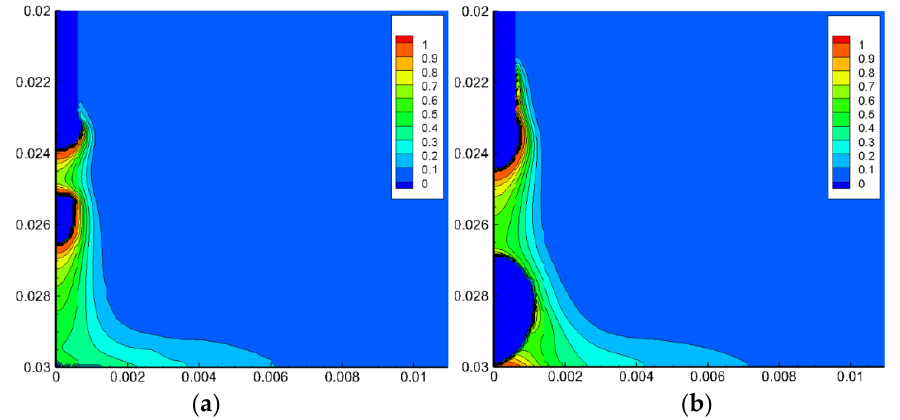
Figure 4. Metal vapor mole fraction distributions in ( a ) conventional MIG welding and ( b ) plasma – MIG welding.